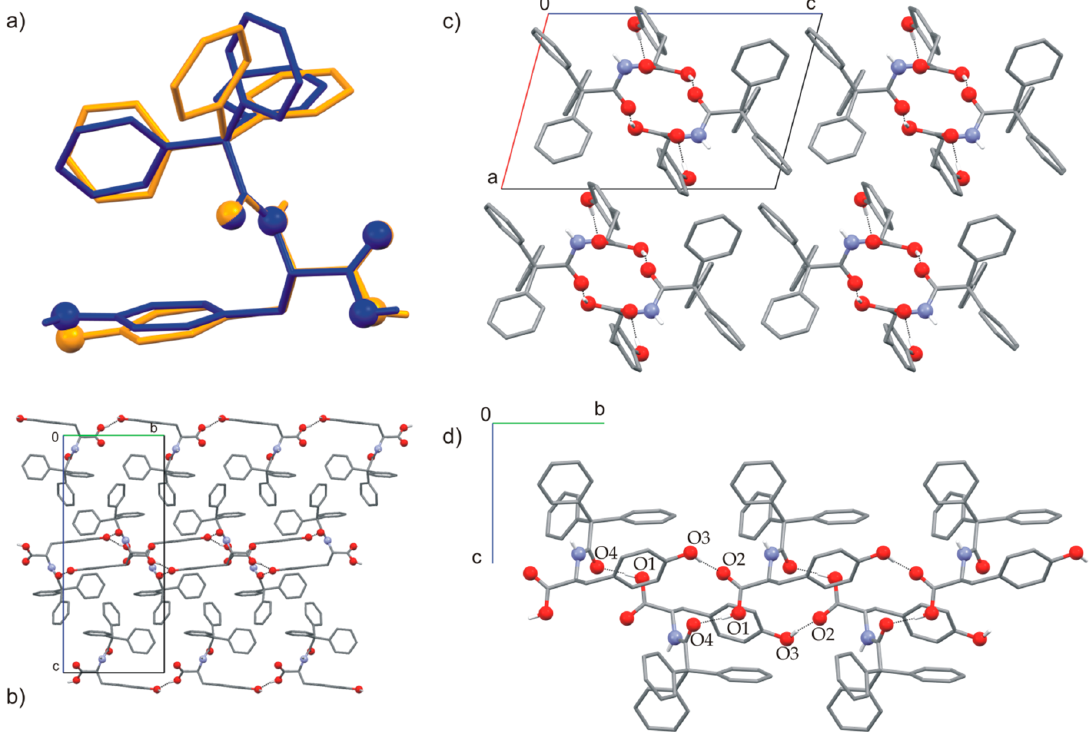
Figure 2. ( a ) Comparison of the molecular conformation of TrCOTyr in polymorph I [42] (orange) and II (blue). Molecular packing in the crystal structure of ( b ) polymorph I, P 2 1 2 1 2 1 (view along x-axis) and ( c ) polymorph II, P 2 1 (view along y-axis); ( d ) 1D motif observed in the crystal structure of polymorph II. The C-bound hydrogen atoms are omitted for clarity. The O and N atoms are shown as balls.